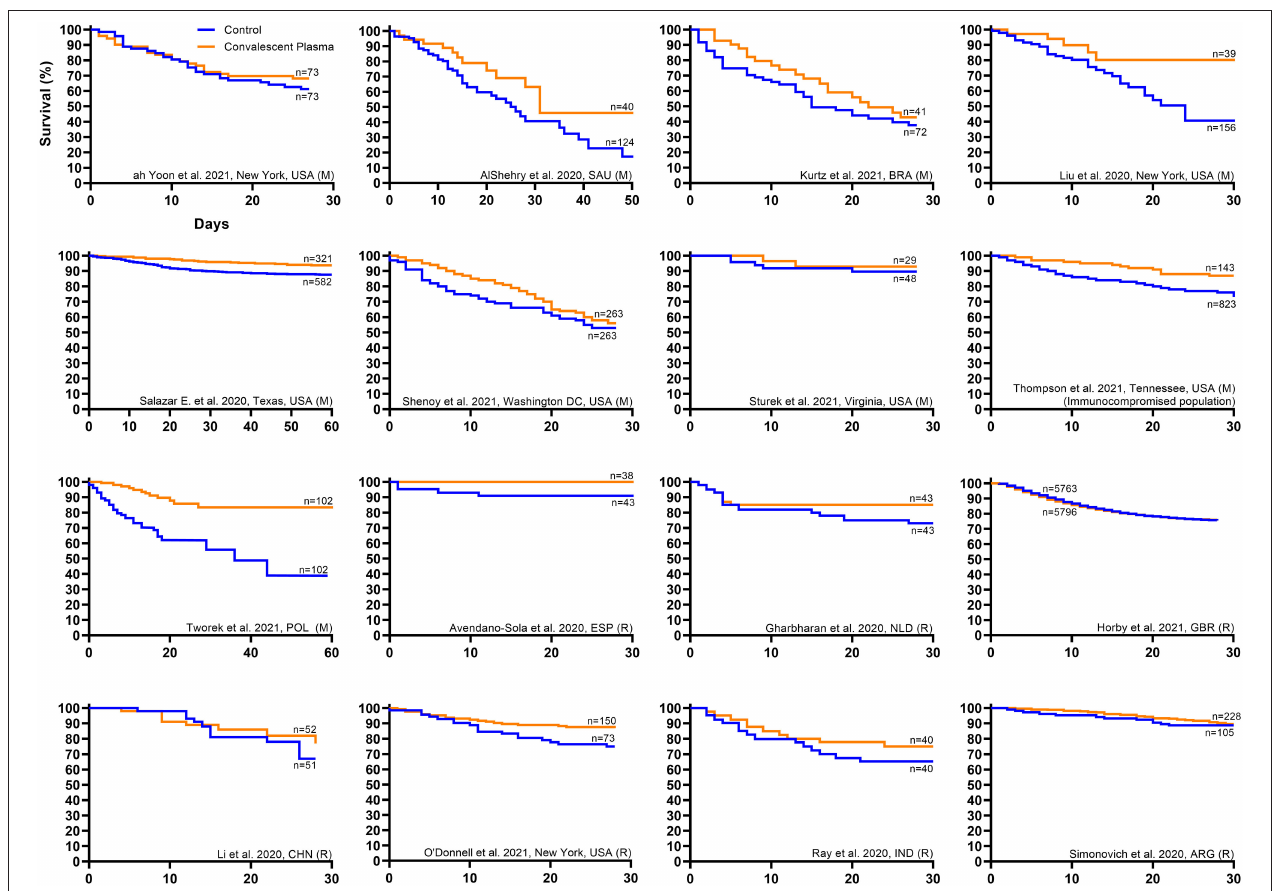
FIGURE 1 | Kaplan–Meier survival plots from worldwide controlled studies investigating convalescent plasma therapy for coronavirus disease 2019 (COVID-19). Available Kaplan–Meier survival data from worldwide controlled studies [ n = 7 randomized clinical trials ( 11, 27, 41, 43, 46, 47, 71) and n = 9 matched-control studies (50, 52, 59–62, 64, 69, 70)] was extracted and replotted. Each panel represents data from one study, where the orange line represents the survival of the cohort transfused with convalescent plasma, and the blue line represents the survival of the cohort that received standard of care or placebo transfusion. The label for each study provides the first author name, location, and study type, where matched-control studies are denoted by (M) and randomized clinical trials are denoted by (R). For each study, sample sizes from the number at risk at study onset are presented for the treatment and control cohorts. No statistical analyses were performed. Interpretation: Qualitative inspection of the Kaplan–Meier survival data from 16 controlled studies revealed a directionally consistent pattern whereby convalescent plasma transfusion was associated with greater patient survival compared to non-transfused